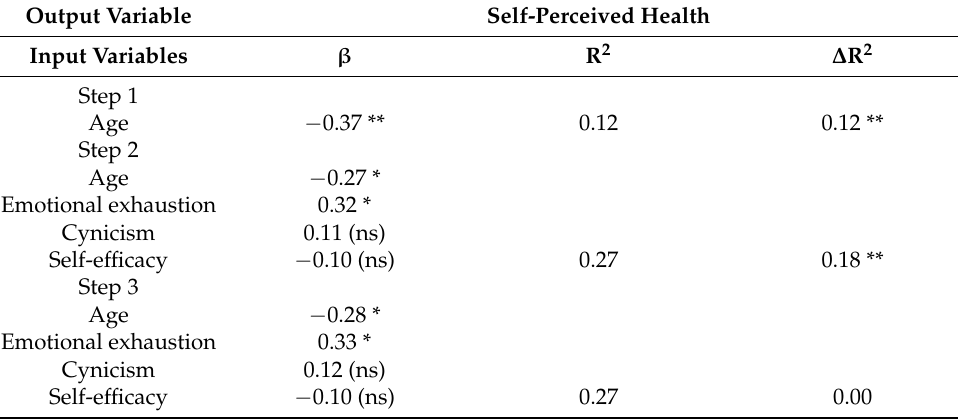
Table 2. Hierarchical regression analysis with self-perceived health as output